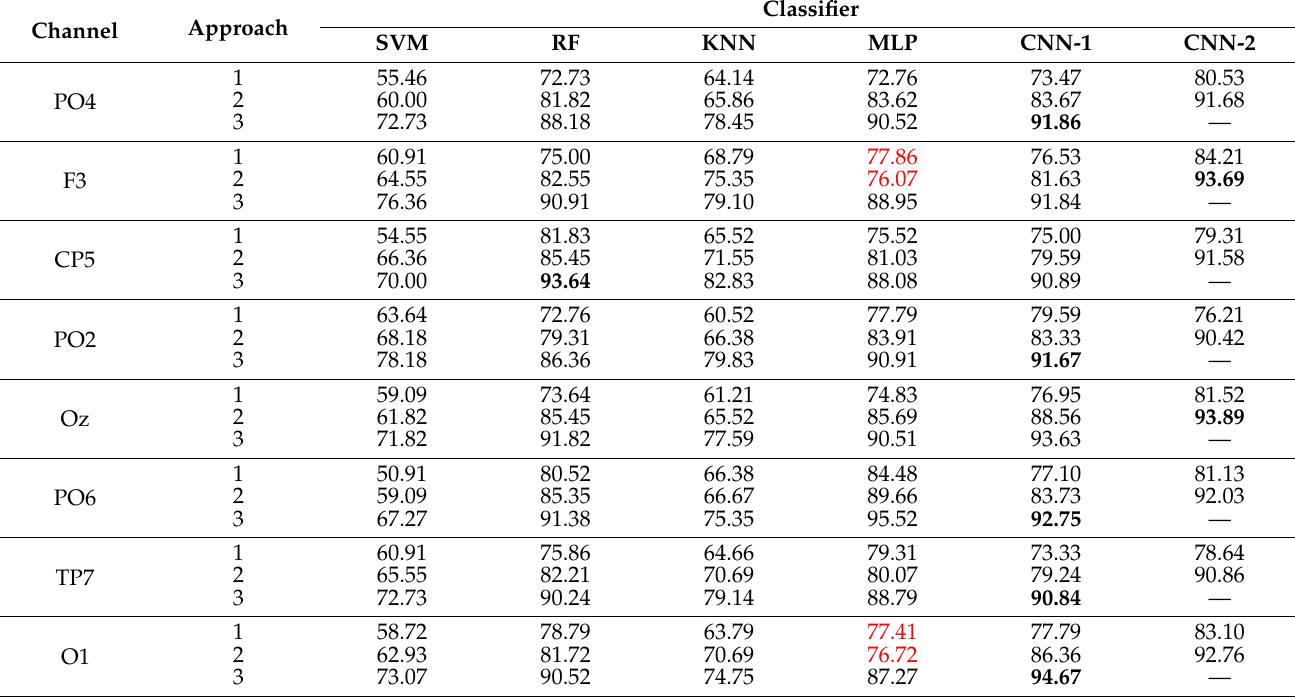
Table A2. Classification accuracies of the ERPs of Subject b 2 . Inconsistent results are highlighted in red. The best result for each channel is highlighted in bold